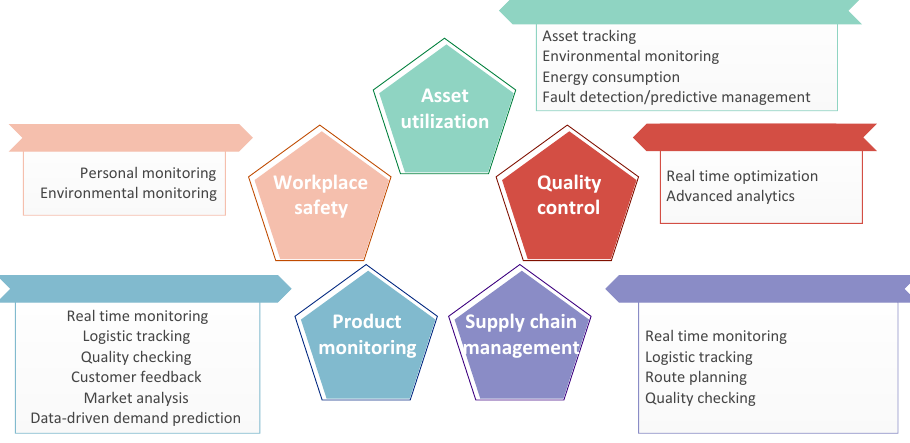
Figure 2. Application domains and related applications in Industry